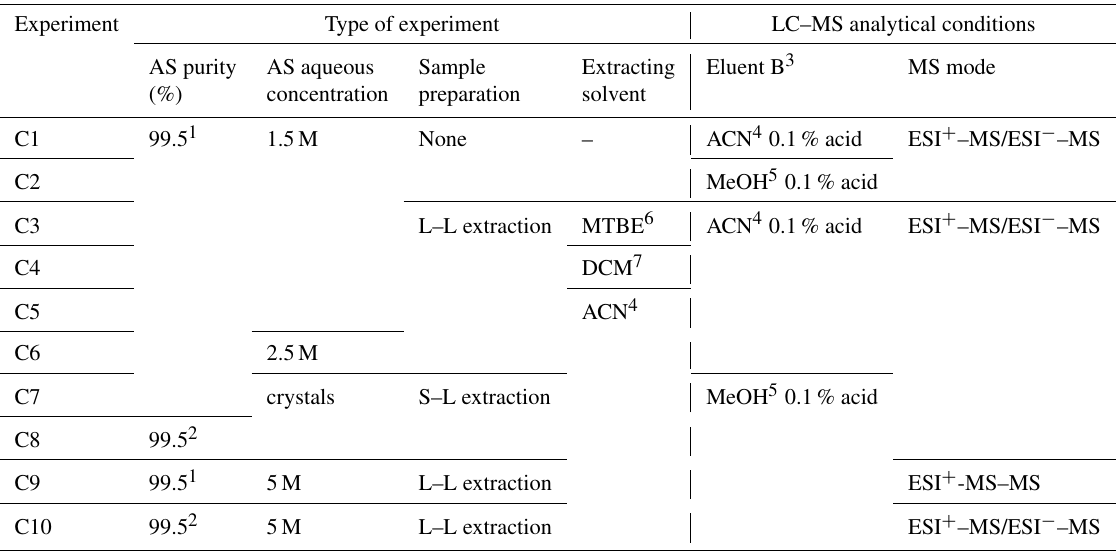
Table 2. Experiments of characterization of organic traces in AS liquid solutions. The elution gradient and ESI setup were the same for all experiments: 1 AS 99.5%, for analysis, from Acros Organics™ Fisher Scientific; 2 AS 99.5% EMSURE ® from Merck; 3 eluents: A = H 2 O with 0.1% formic acid, and B as specified; 4 acetonitrile, 5 methanol, 6 methyl tert-butyl ether, 7 dichloromethane; L–L: liquid–liquid, S–L: